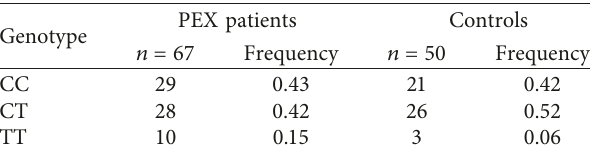
Table 4: Genotype frequencies of rs2279590 polymorphisms in Polish population.